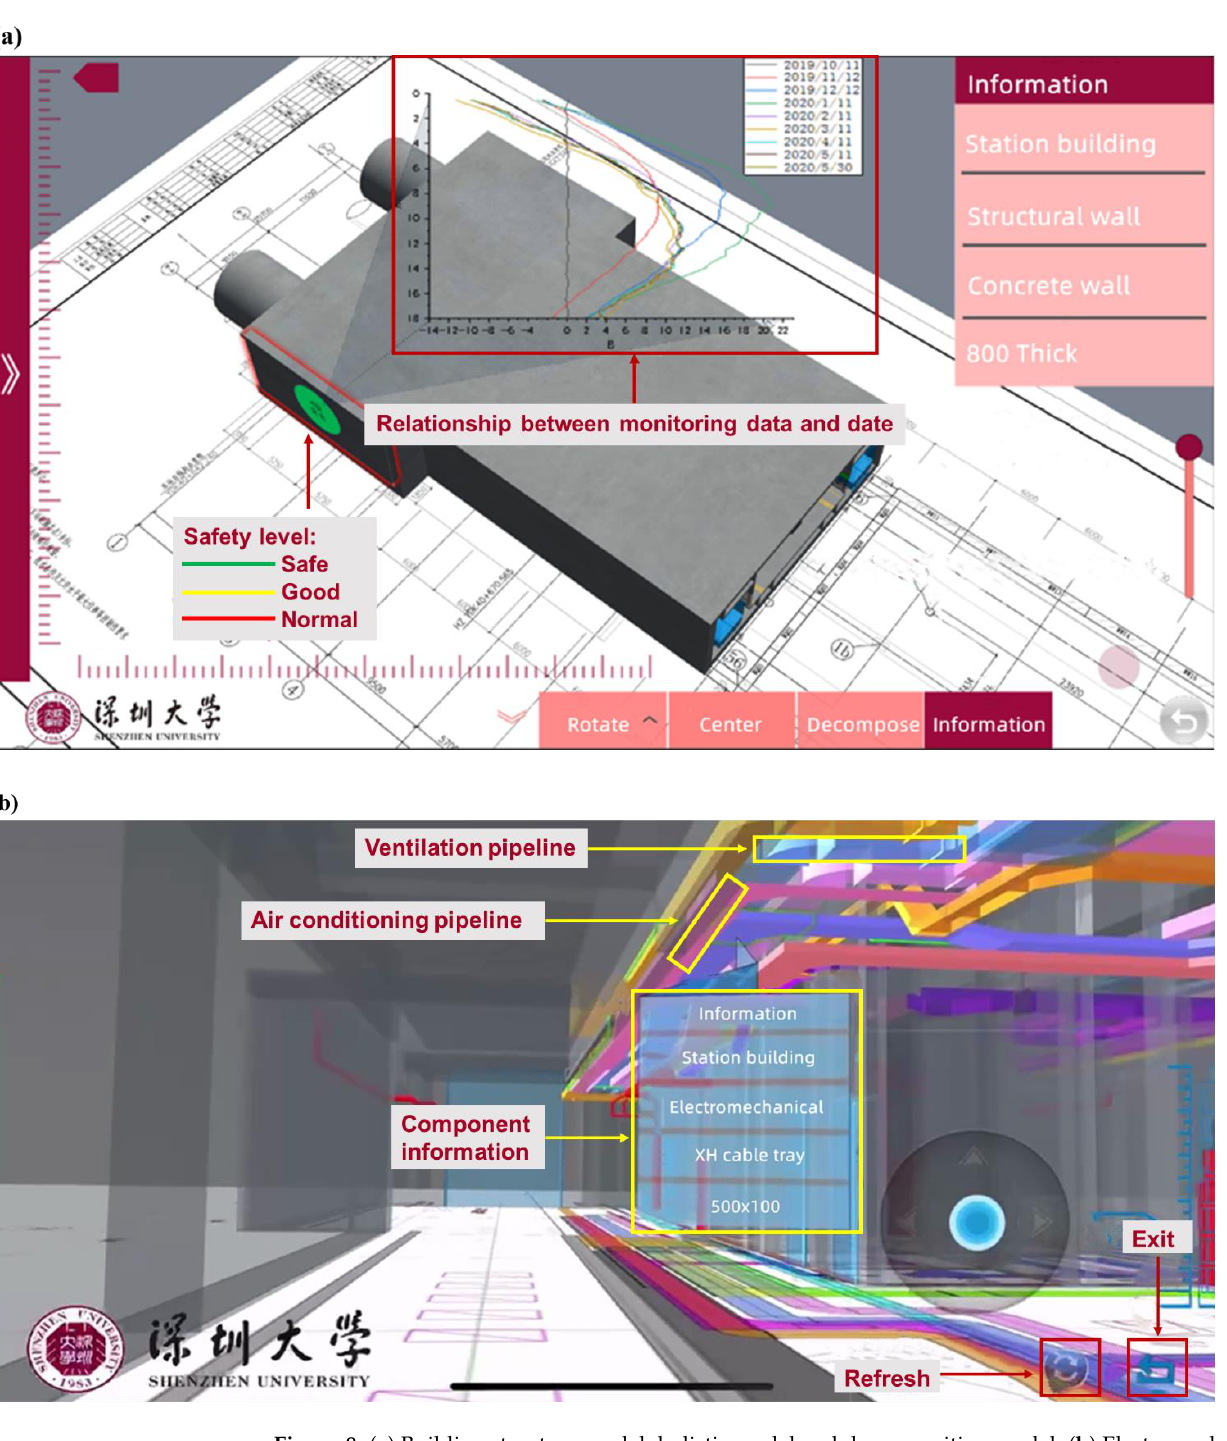
Figure 8. ( a ) Building structure model: holistic model and decomposition model. ( b ) Electromechan- ical pipeline model, holistic model and decomposition model.